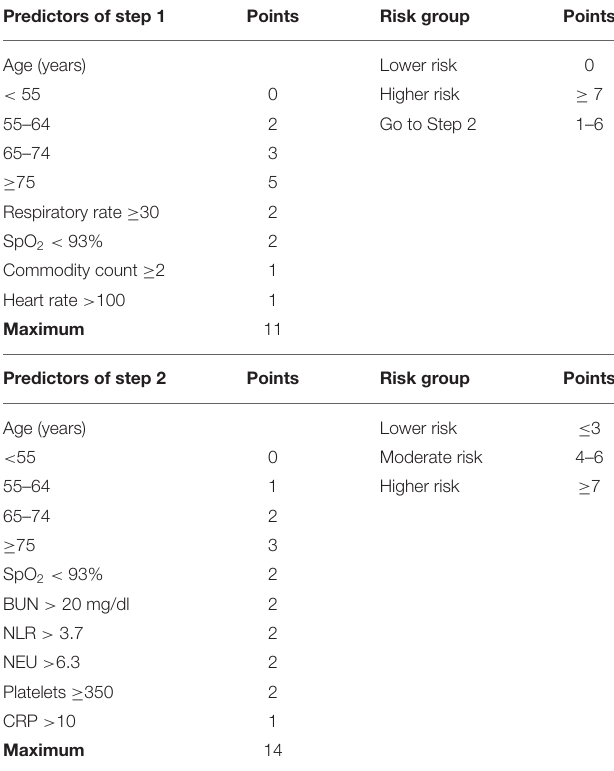
TABLE 1 | The proposed two-step risk score for coronavirus disease 2019 mortality.